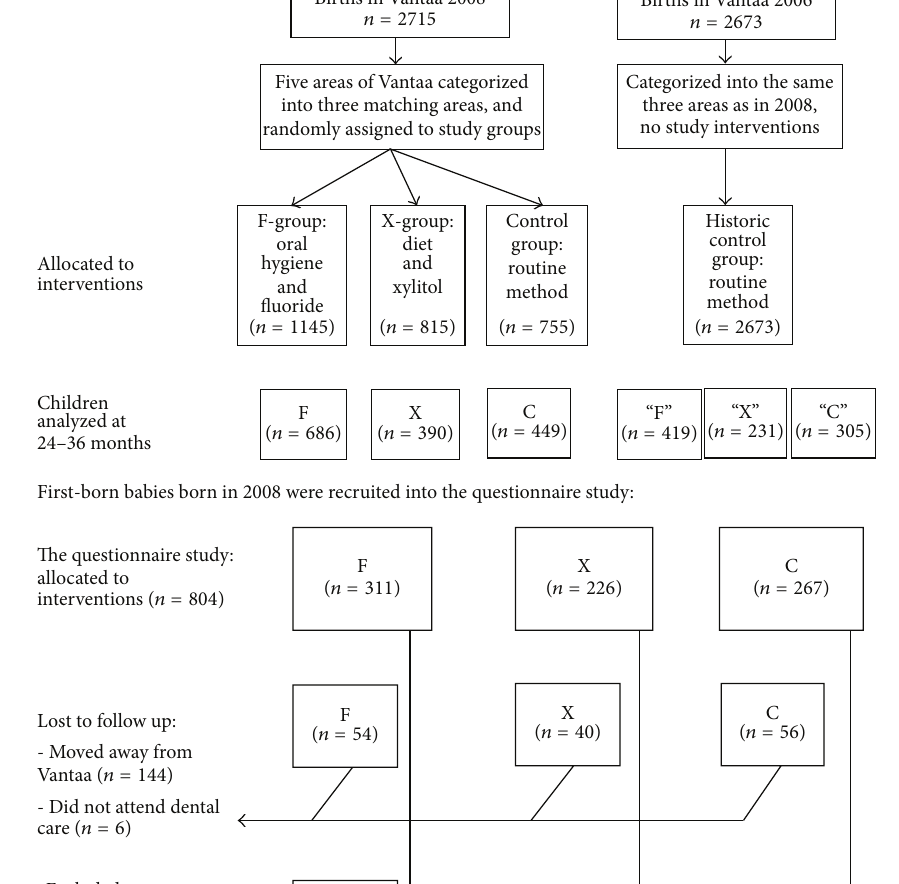
judgment of the author (IA) who interpreted all tests for